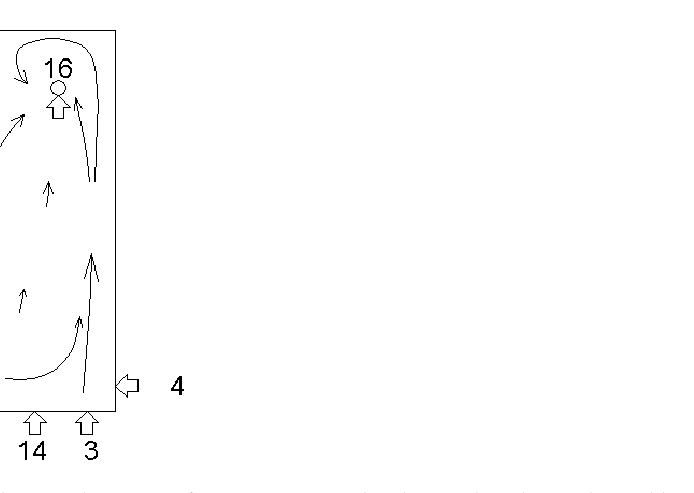
Figure 4. Schematic of heat exchange configuration B4, with inlets and outlets indicated by white arrows and expected flow lines (not calculated) indicated by black arrows.